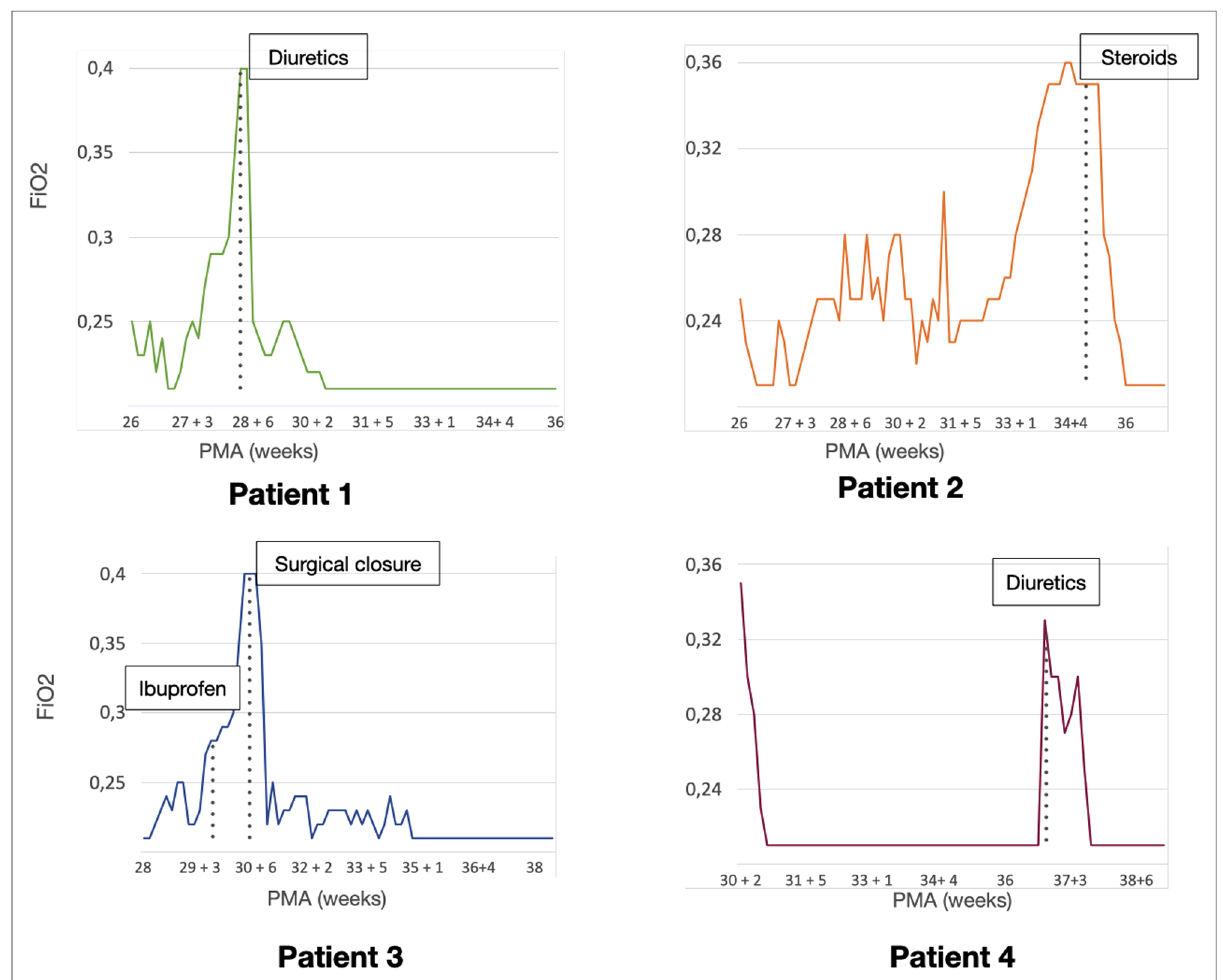
FIGURE 3 Patient clinical course. Graphics representing the need for respiratory assistance of each patient. The vertical axis shows the mean fraction of inspired oxygen (FiO2) needs for each day, the horizontal axis represents the post-menstrual age (PMA). The time-point for each speci fi c (cardiopulmonary ultrasound (CPUS) guided intervention is highlighted in each